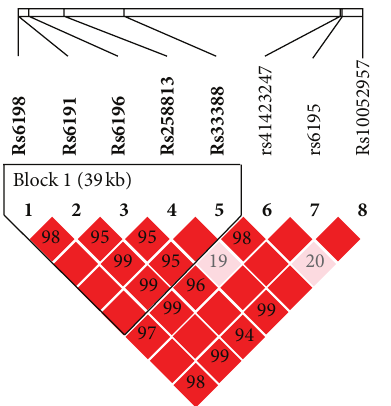
Figure 1: Relative positions and LD estimates between NR3C1 polymorphisms in the analyzed population. Coloured squares cor- respond to 𝐷 󸀠 values with numerical estimates given within the squares.